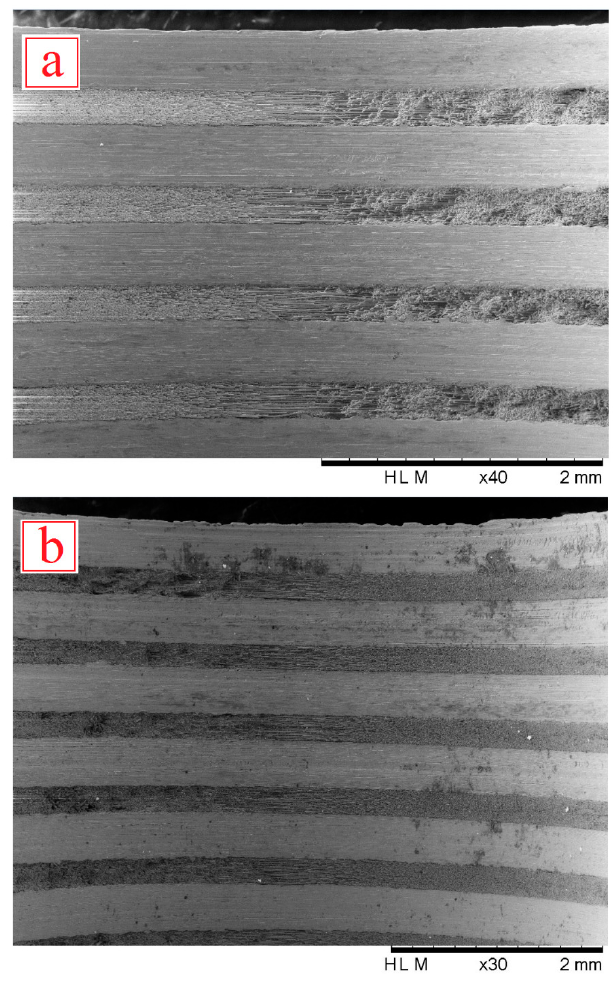
Figure 9. SEM images of the upper borehole surface condition of holes under ( a ) MQL and ( b ) dry.